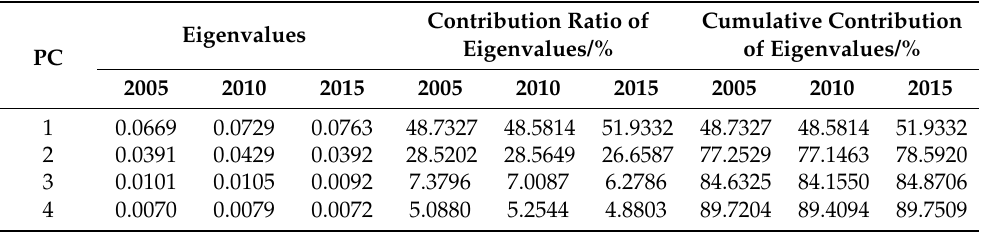
Table 5. Results of the SPCA (spatial principal components analysis) of ecosystem vulnerability on the Qinghai-Tibet Plateau.